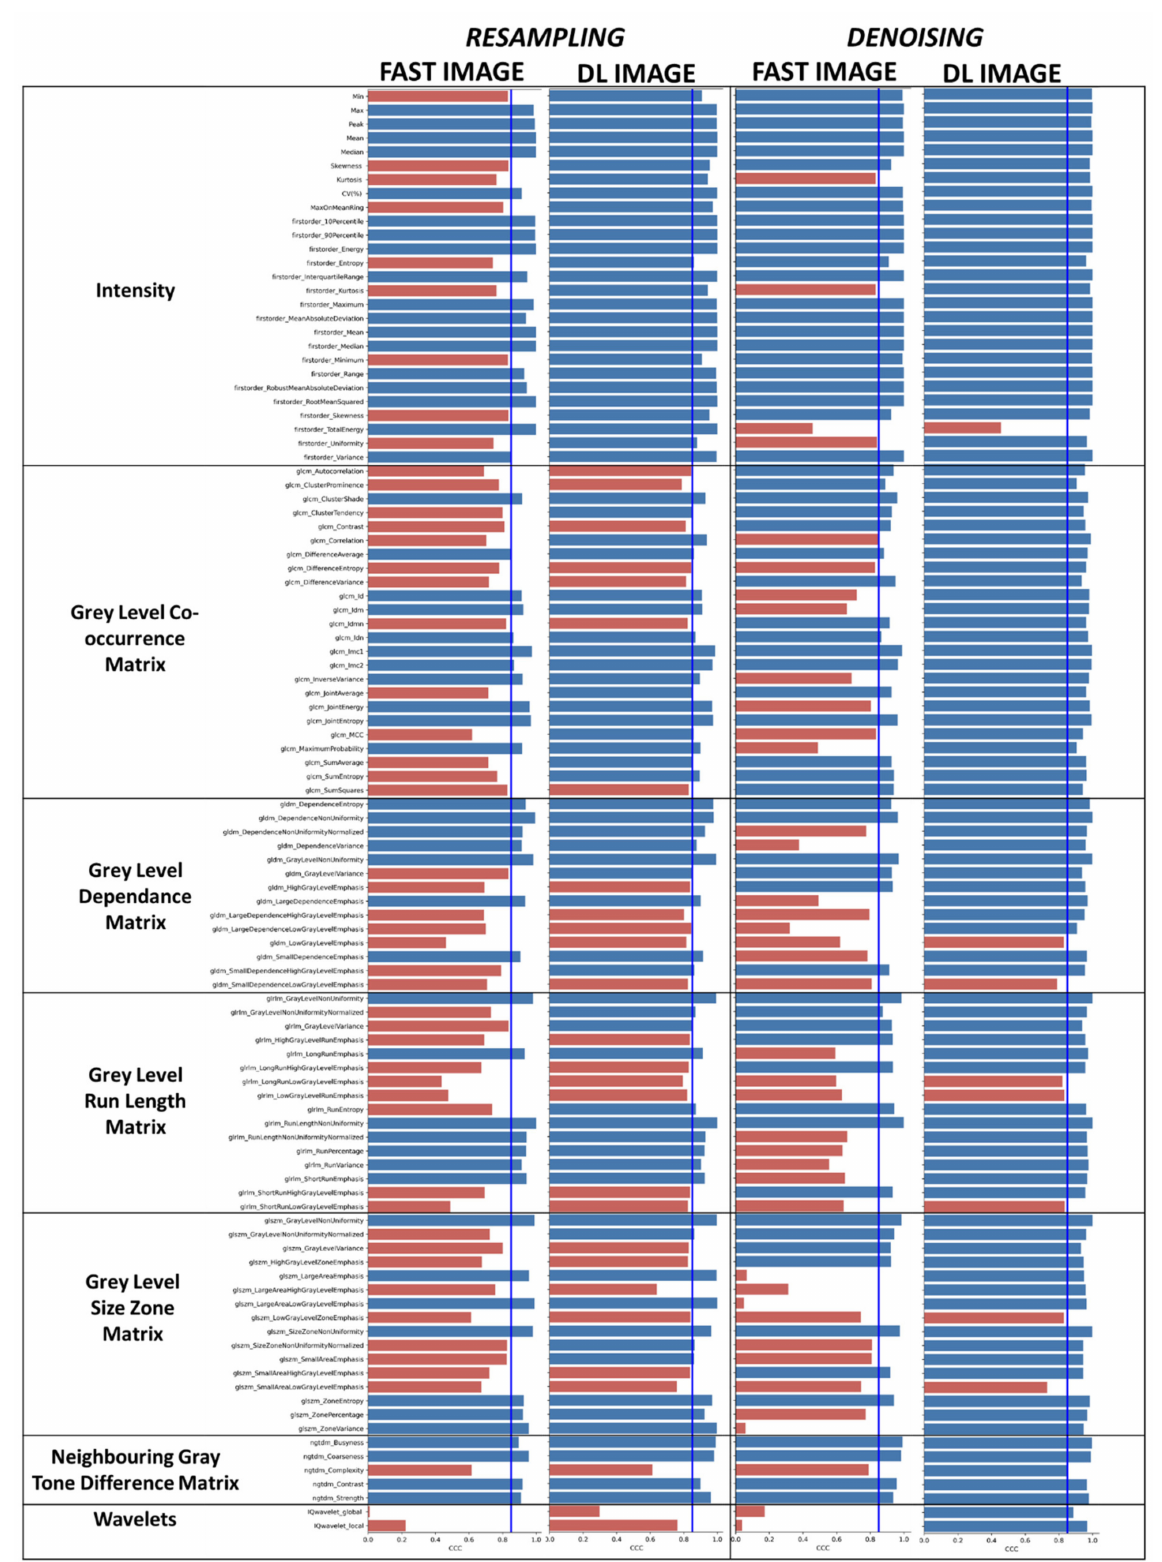
Figure 4. Effect of fast acquisition and resampling DL model on the correlation between reference and post-processing image radiomic values. Red bars represent unstable radiomic features below a CCC value threshold of 0.85. Blue bars represent stable radiomic features after fast acquisition or resampling DL